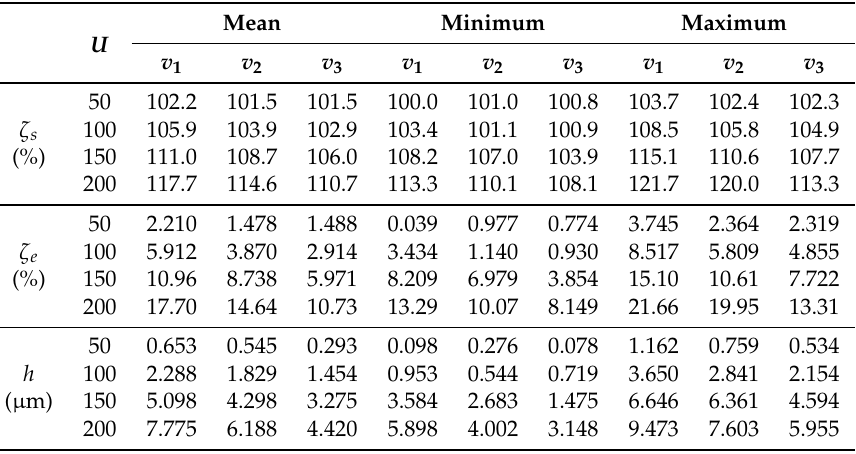
Figure 6. Basic characters of micro letters fabricated by MEJM. Table 4. Descriptive statistic of micro